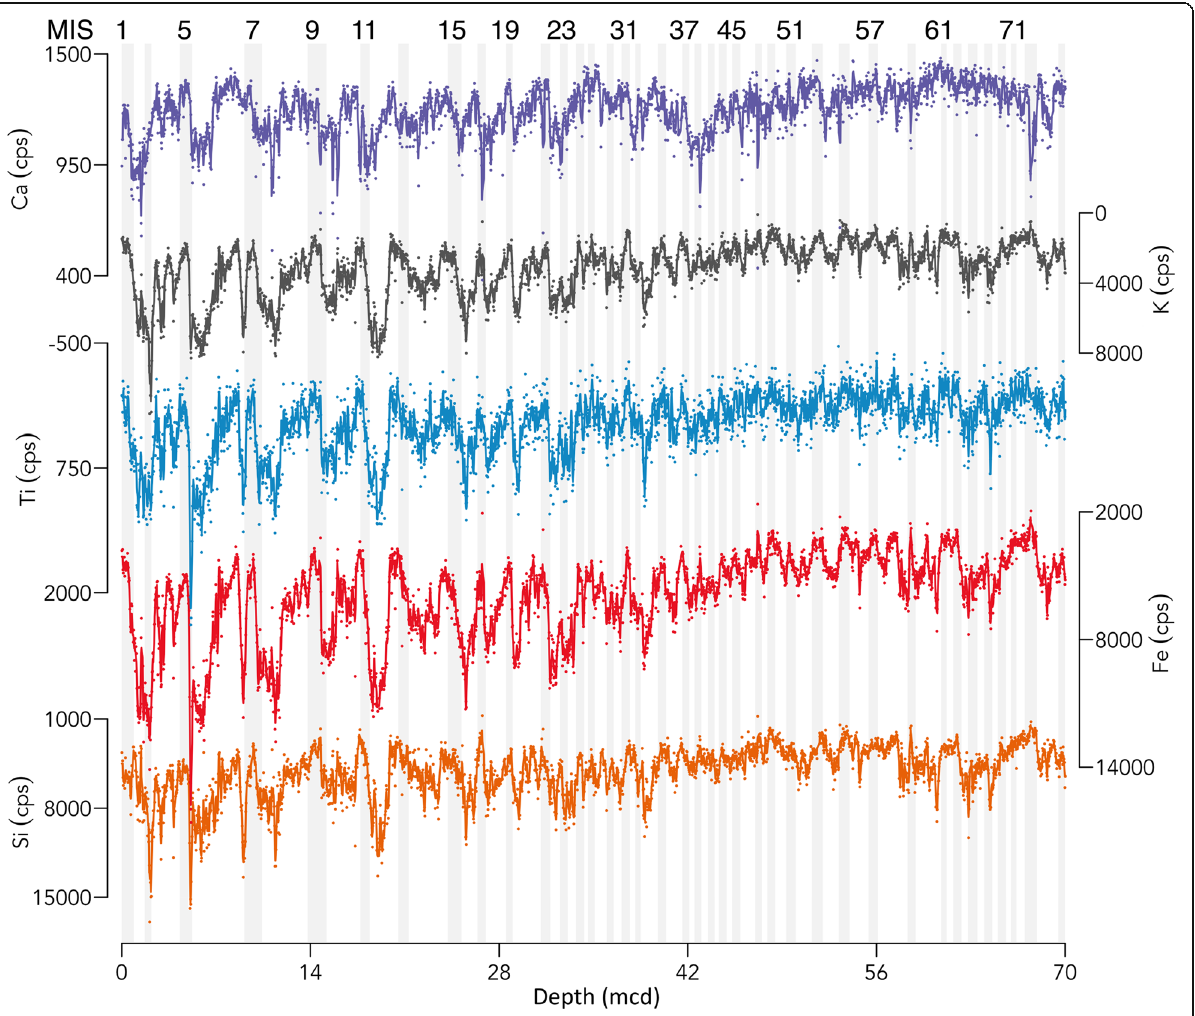
Fig. 6 The element intensity (cps = counts per second) time-series of terrigenous input transported by wind versus shipboard composite depth as measured by the non-destructive XRF core-scanner at College Station, Texas A&M University. MIS are shown, dots indicate measured XRF core- scanner data points; a three-point moving average smoothing was applied (bold line) to highlight the